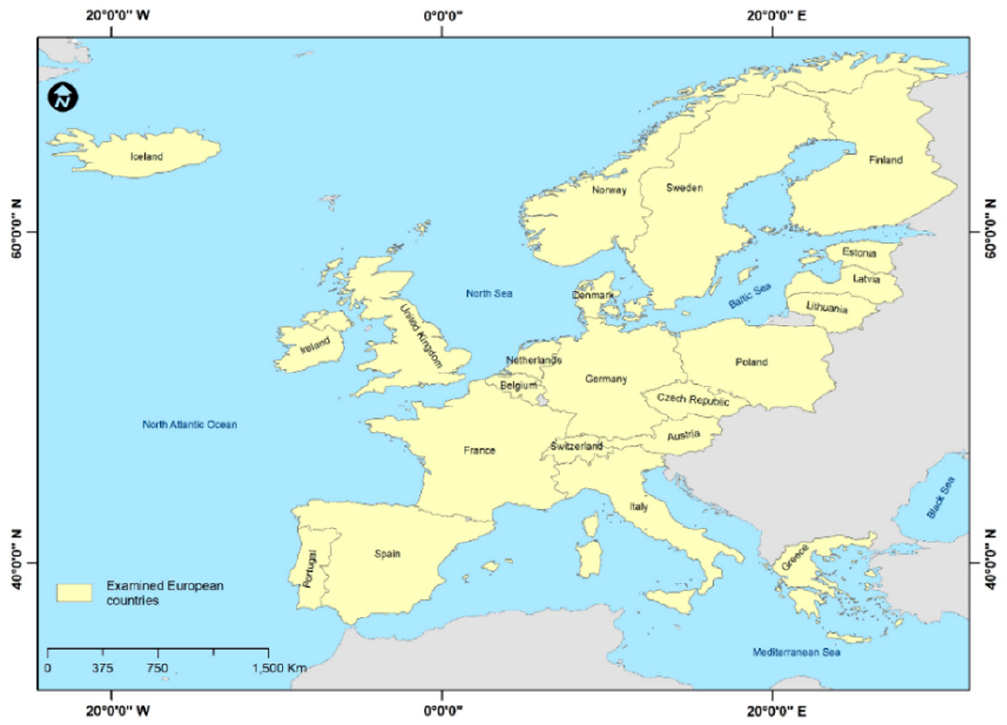
Figure 1. European countries examined in the